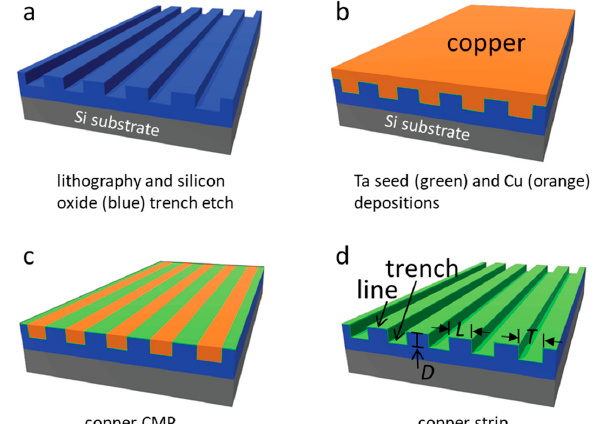
Figure 1. Schematic drawings illustrate the tantalum (green) comb structure fabrication method. ( a ) Patterns were transferred to the silicon oxide films using lithography and plasma etching techniques. ( b ) Tantalum seed and copper films were deposited on the etched patterns. ( c ) Excess copper was with nitric acid. The comb structure contains line (L) and trench (T) of equal widths. All trenches had the same depth